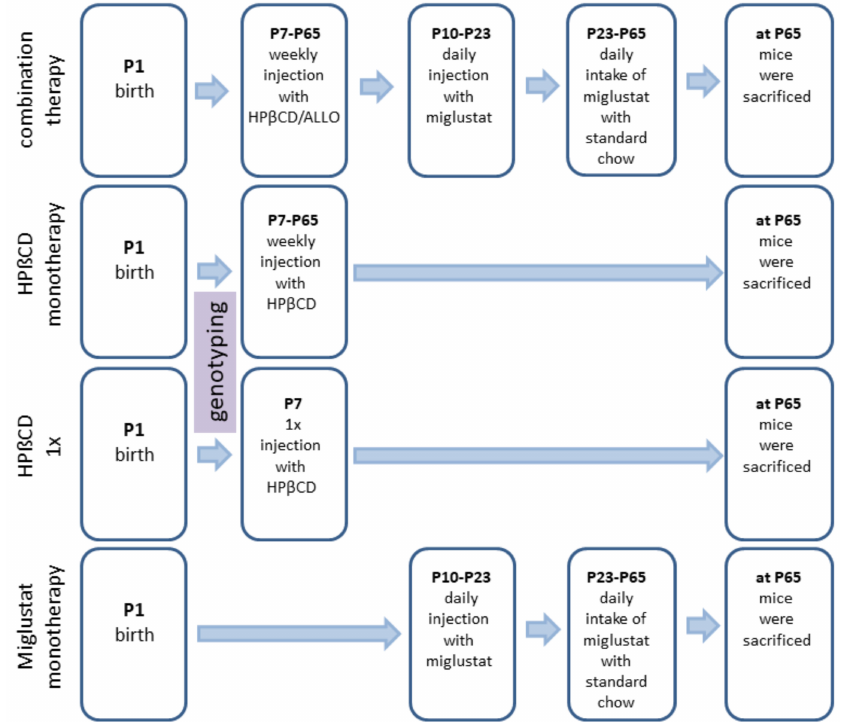
Figure 9. Timeline of drug administrations for all experimental groups. Mice of the Sham groups were injected with the respective amounts of 0.9% NaCl according to the treatment plan of the combination- treated group. At P7 and thenceforth, NPC1 mice were injected weekly with allopregnanolone (25 mg/kg; Sigma Aldrich, St. Louis, MO, USA) dissolved in HPßCD (4000 mg/kg; Sigma Aldrich, Munich, Germany). At P10 and until P23, animals were injected daily with miglustat (300 mg/kg, i.p.; Zavesca; Actelion Pharmaceuticals, San Francisco, CA, USA). From P23 onward, animals were fed with miglustat included in standard chow (1200 mg/kg per day) until